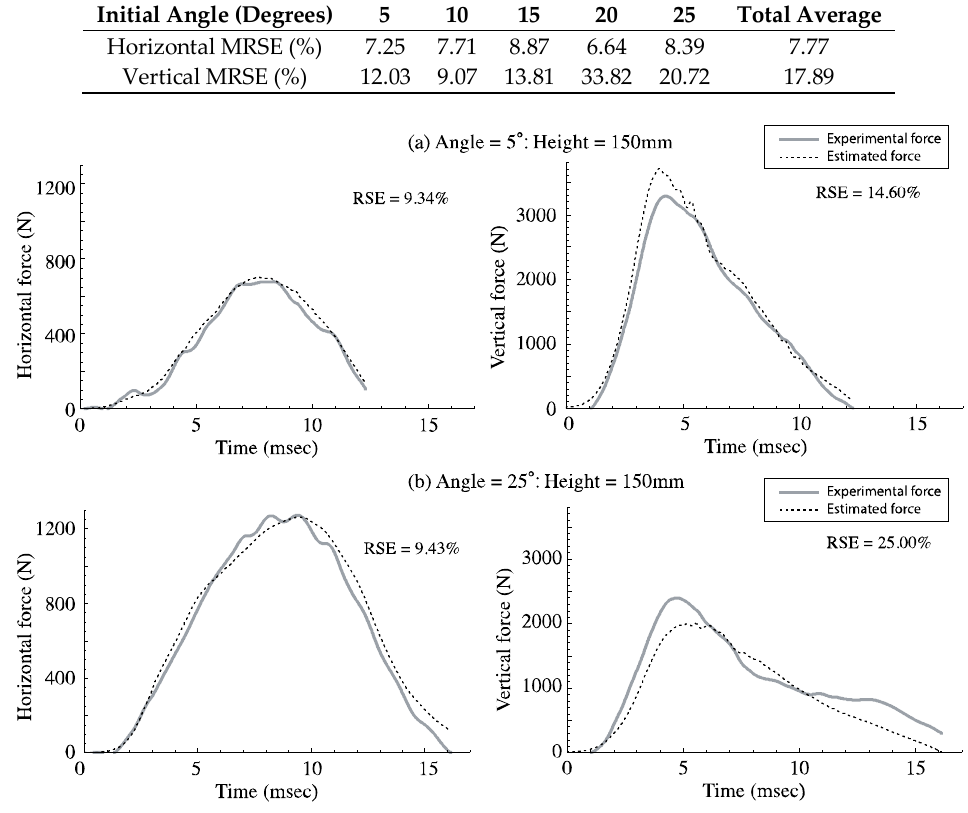
Figure 4. Comparison of experimental force and estimated force at ( a ) 5-degrees initial angle and 150-mm drop height; and ( b ) 25-degrees initial angle and 150-mm drop height. The left panels show the horizontal force and the right the vertical